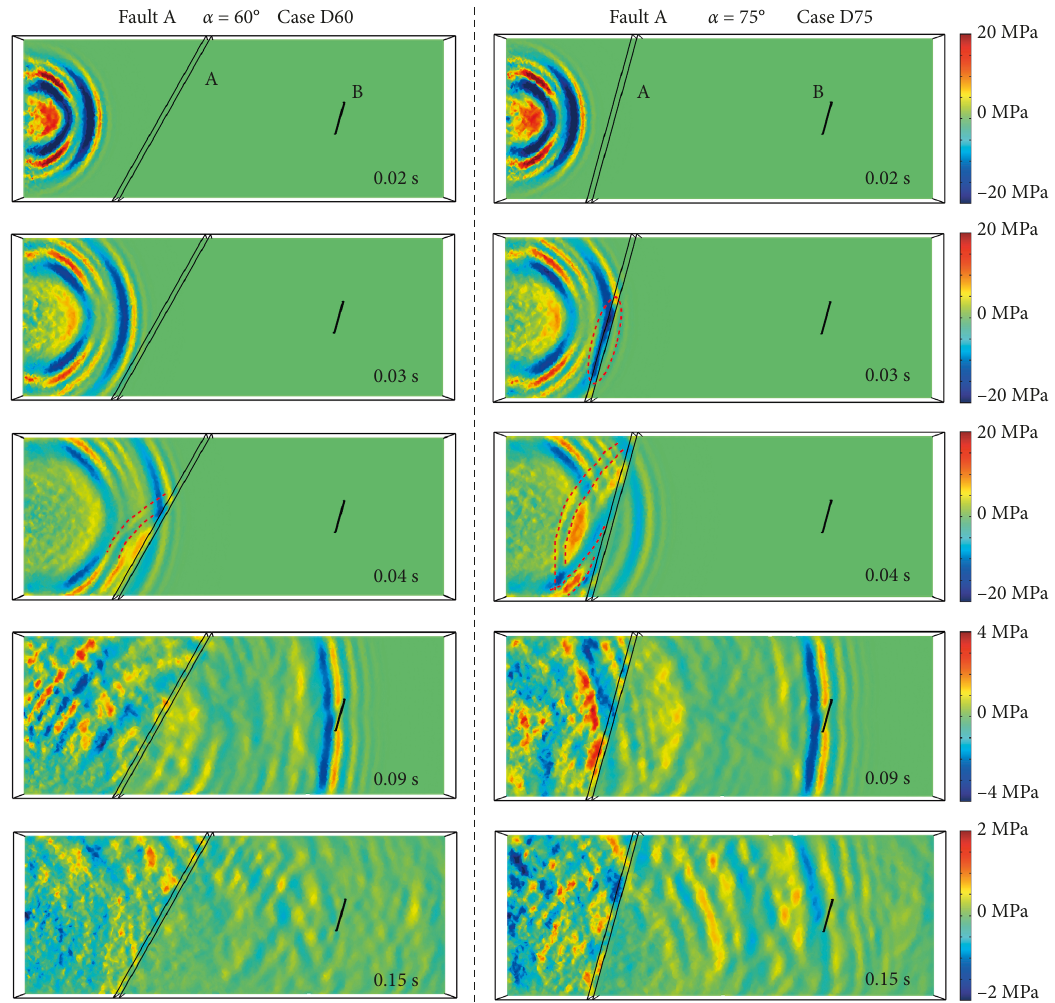
Figure 3: The cross section in the middle of the model box (Figure 1) showing the evolution and distribution of the stress in the XX direction when the dip angle ( α ) of fault A was set to 60 ° and 75 ° , respectively. The faults were indicated with black lines and purple front (A and